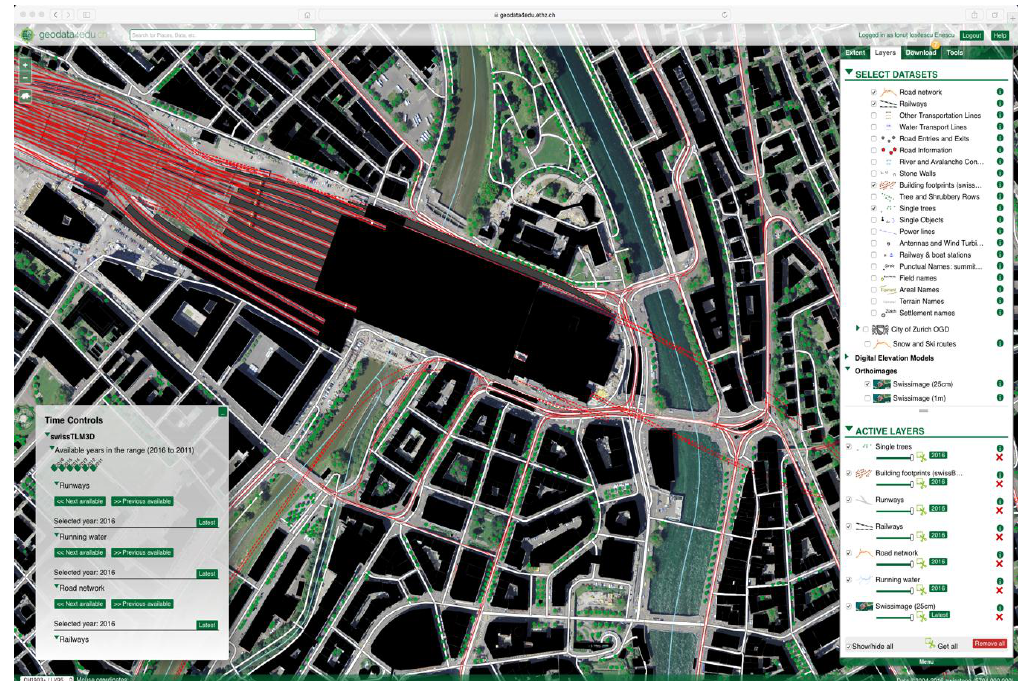
Figure 1. The GeoVITe geoportal provides a download service for the Swiss national portal for geodata in teaching and research—geodata4edu.ch; Geodata © 2016 swisstopo (JD100042).